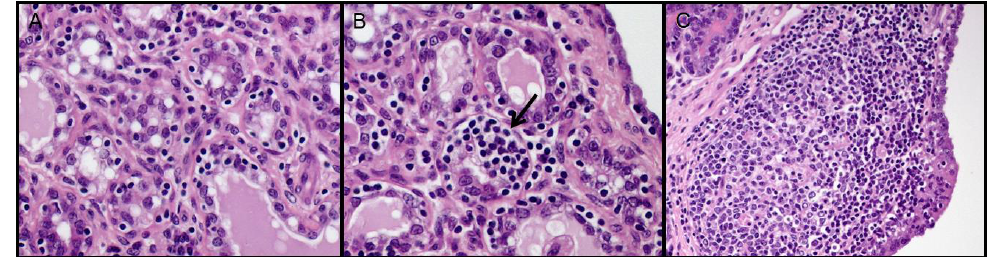
Figure 1. SRLV lesions in mammary gland of sheep. ( A ) Minimal lesion (+) with small focal lymphocyte aggregates within the mammary interstitium. 40×. ( B ) Black arrow indicates moderate (++) focal inflammatory lesion surrounded by minimal lymphocytic infiltrates. 40×. ( C ) Large lymphoid follicle in a severe lesion (+++). Hematoxylin and eosin (HE) staining. 20×.